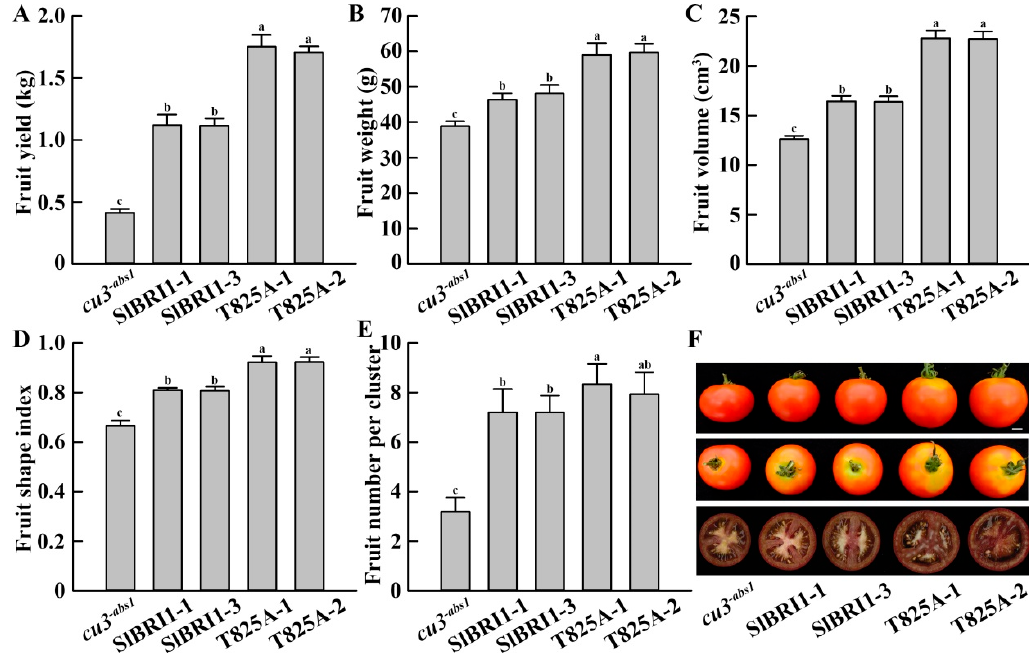
Figure 4. SlBRI1 T825A improves tomato yields. ( A ) Fruit yield per plant for the first to fourth fruit nodes. ( B – D ) Single fruit weight ( B ), fruit volume ( C ), and fruit shape index ( D ) at the red ripening stage. The fruit shape index is the ratio of the longitudinal diameter to the transverse diameter of the fruit. ( E ) Fruit number per cluster for the third cluster. ( F ) Top, phenotypes of single fruits with a front view. Middle, phenotypes of single fruits with a top view. Bottom, the equatorial sections of single fruits. Scale bar represents 1 cm. The data for ( A) are presented as the mean ± SD ( n = 6). The data for ( B – E ) are presented as the mean ± SD ( n = 15). The different letters indicate significant differences (one-way ANOVA, Tukey’s test, p < 0.05).